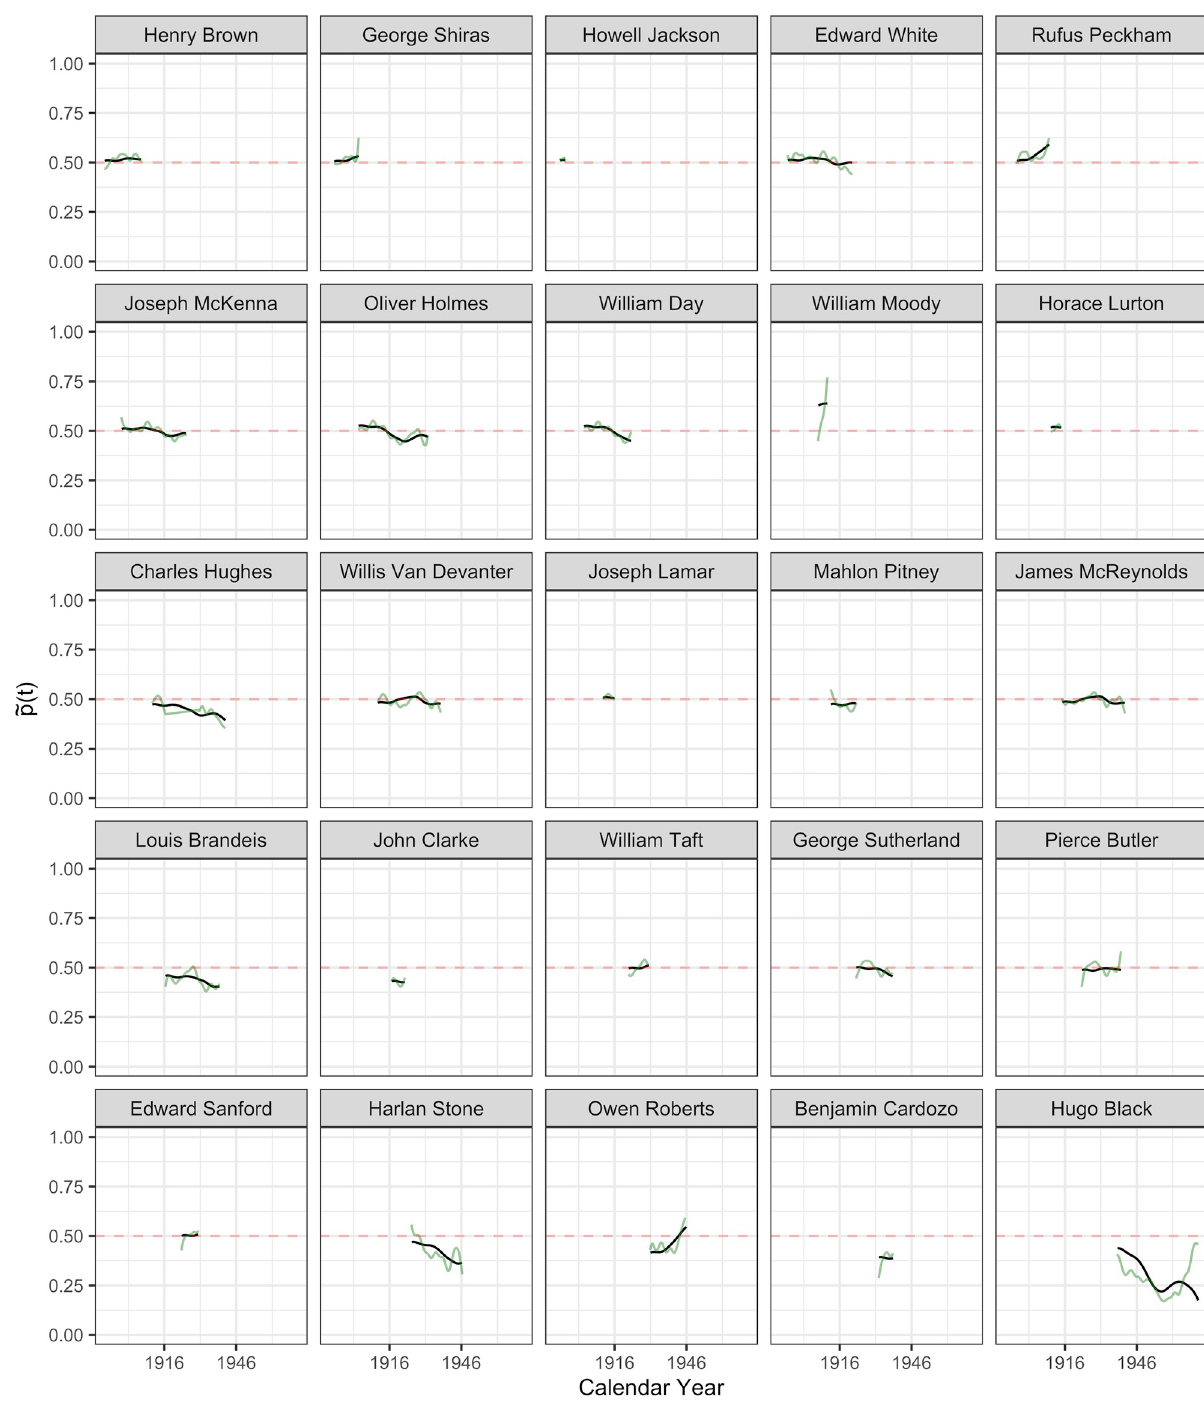
Fig 7. The inferred latent ideology processes ~ p ð t Þ are shown in black and the observed (smoothed) processes ^ p processes ~ p i